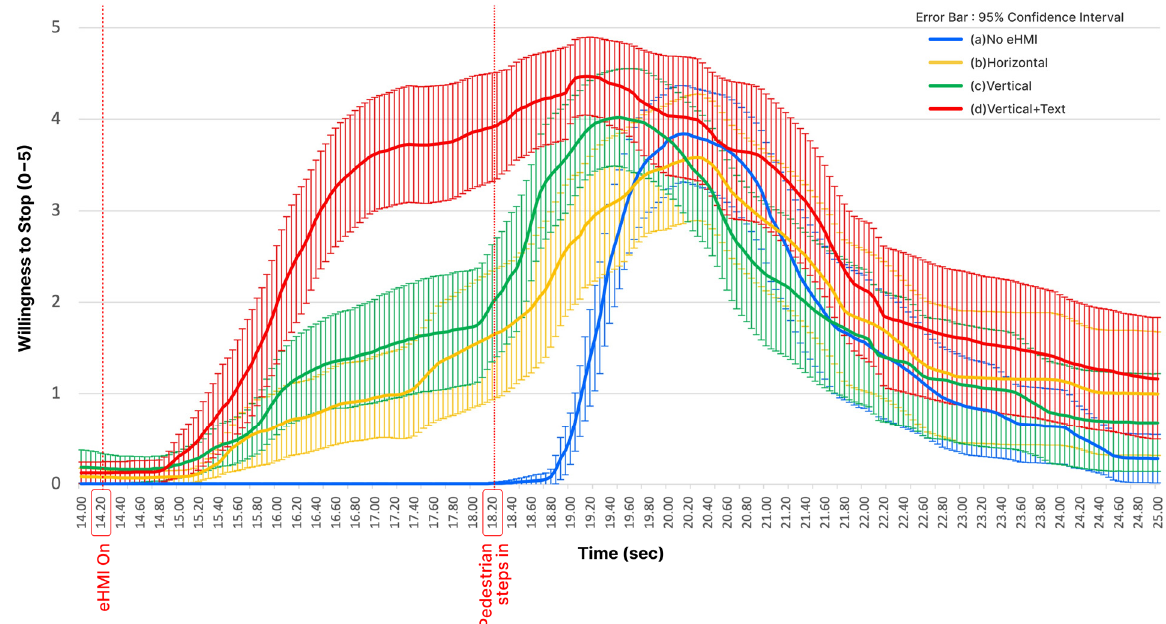
Figure 5. Willingness to stop (continuous data logs from 0 to 5) by four tested cases.